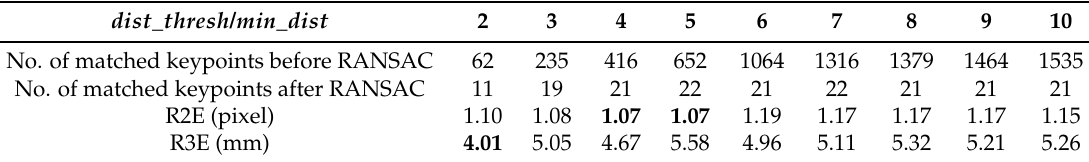
dist _ thresh / min _ dist